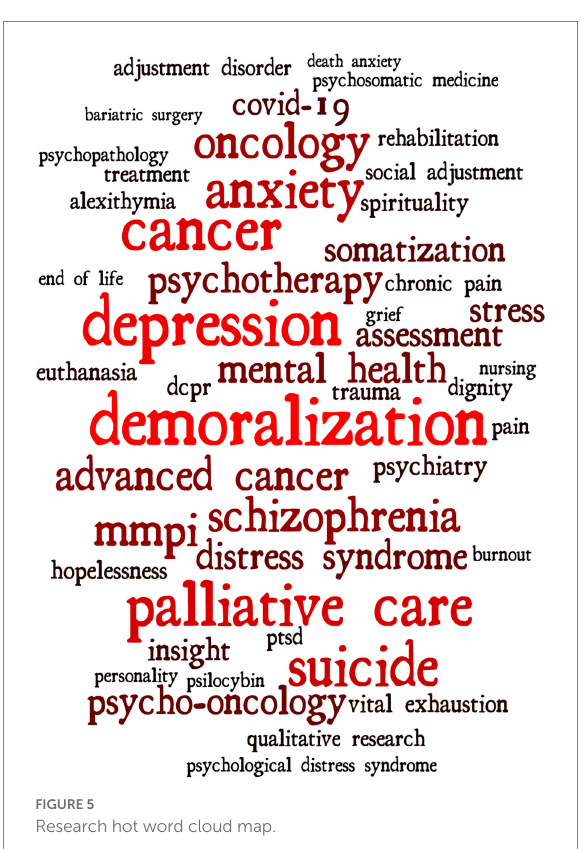
FIGURE 5 Research hot word cloud